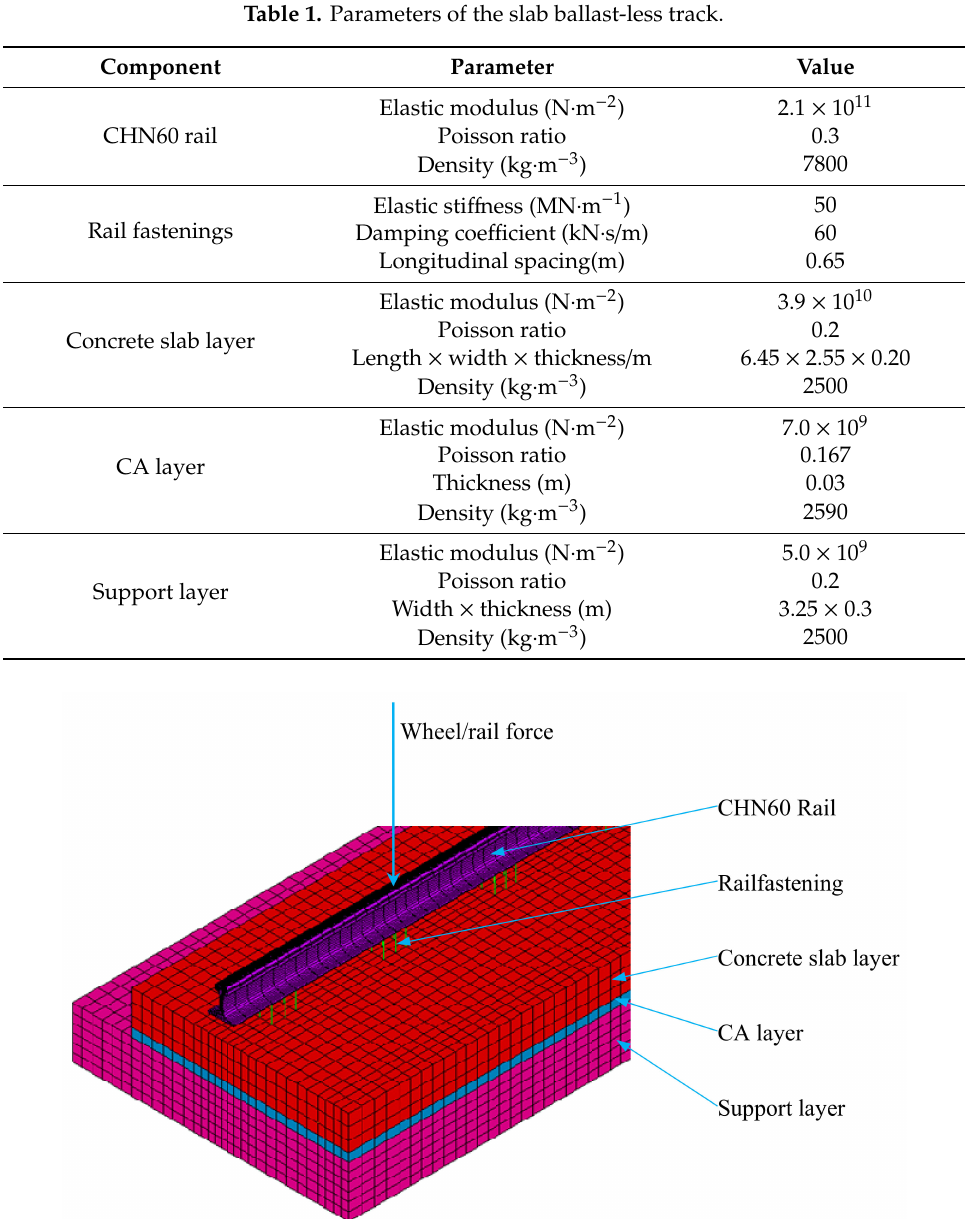
Figure 4. Illustration of 3D finite element (FE) model of slab